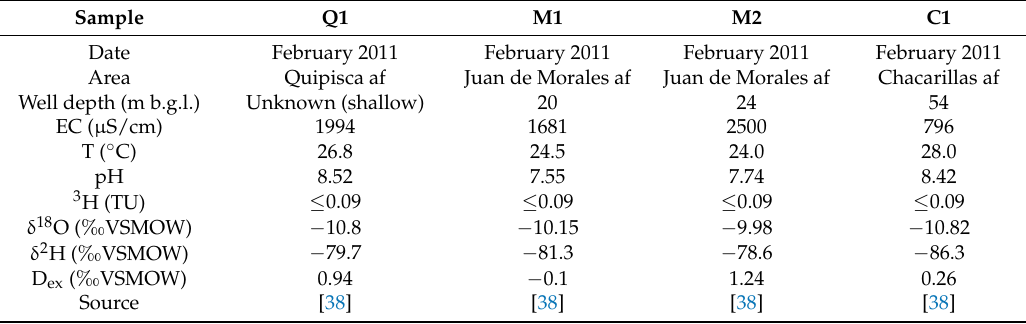
Table 3. Isotope data of shallow groundwater at alluvial fans (alluvial fan = af, EC = electrical conductivity) (position of wells displayed in Figure